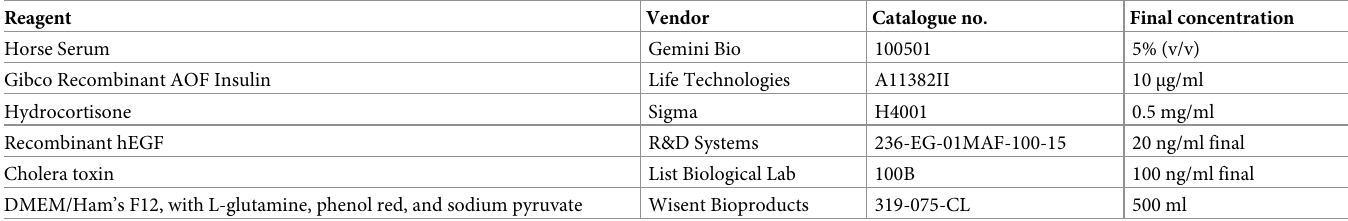
Table 1. Culture medium composition for MCF10A breast epithelial